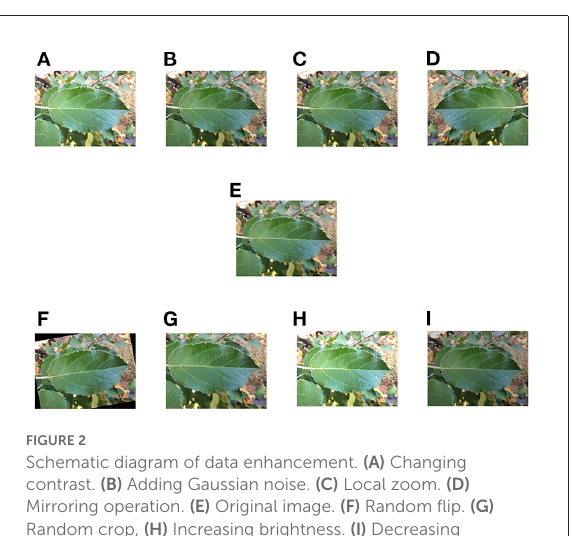
FIGURE2 Schematic diagram of data enhancement. (A) Changing contrast. (B) Adding Gaussian noise. (C) Local zoom. (D) Mirroring operation. (E) Original image. (F) Random flip.